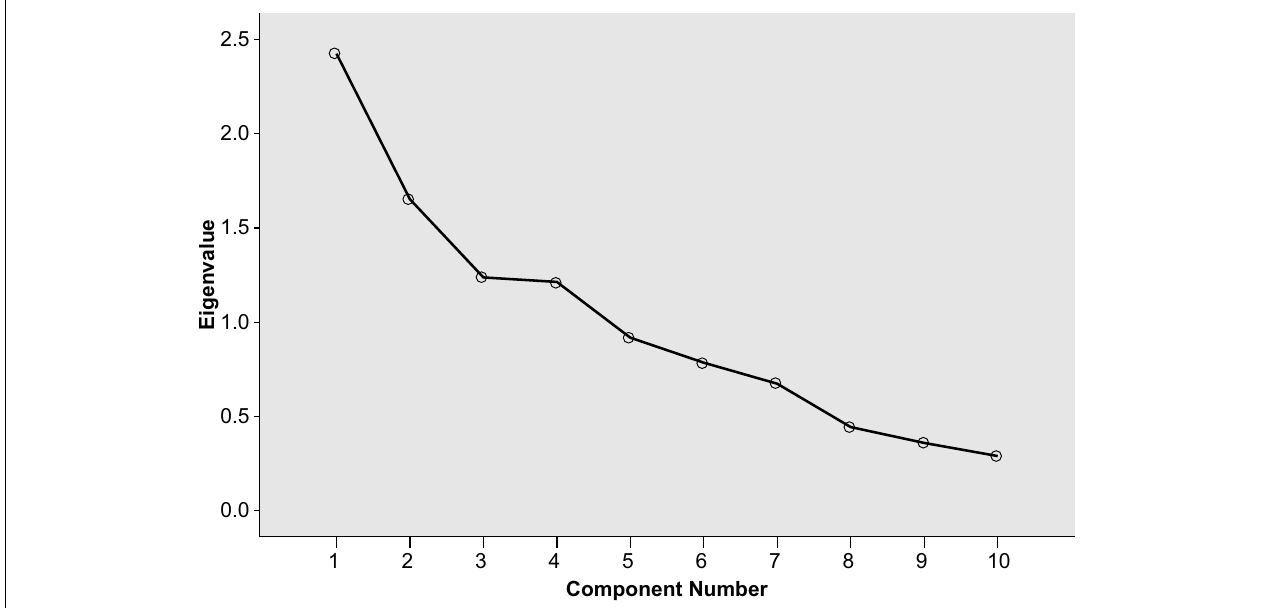
FIGURE 1 | Scree plot showing the eigenvalues of the fi ve extracted components and residual